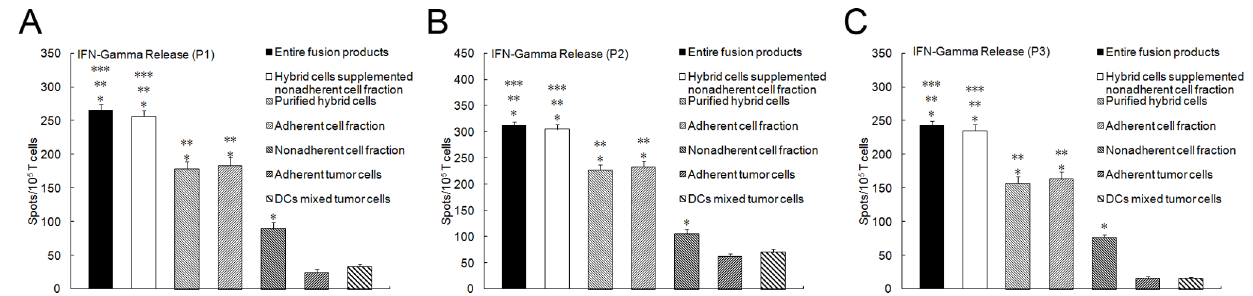
Figure 3. IFN-gamma production stimulated with purified DC/tumor hybrids or other components of the fusion products. Non- adherent PBMCs, purified using nylon wool, were co-cultured with purified hybrid cells, adherent tumor cells, the non-adherent cell fraction, the adherent cell fraction, purified hybrid cells supplemented with the non-adherent cell fraction, total fusion products, or DCs mixed with tumor cells at a ratio of 10:1 in complete RPMI 1640 for 7 days and then harvested as effector cells using nylon wool separation. Patient-derived tumor cells were used as stimulator cells. IFN-gamma production was determined using a human IFN-gamma ELISPOT kit. A medium-only control and tumor cells without effector cells were included as negative controls. Columns , mean values of triplicate samples; bars , SD. * P , 0.05 for the number of IFN-gamma positive T cells induced by purified hybrids, the adherent cell fraction, the non-adherent cell fraction, total fusion products or purified hybrid cells supplemented with the non-adherent cell fraction compared to DCs mixed with tumor cells. ** P , 0.05 for the number of IFN-gamma positive T cells induced by total fusion products, purified hybrid cells supplemented with the non-adherent cell fraction, purified hybrid cells or the adherent cell fraction compared with non-adherent cell fraction. *** P , 0.05 for the number of IFN-gamma-positive T cells induced by total fusion products or purified hybrid cells supplemented with the non-adherent cell fraction compared with purified hybrid cells or the adherent cell fraction. There was no difference between total fusion products and purified hybrid cells supplemented with the non-adherent cell fraction or between purified hybrids and the adherent cell fraction ( P . 0.05). (A from patient1, B from patient2, C from patient3).